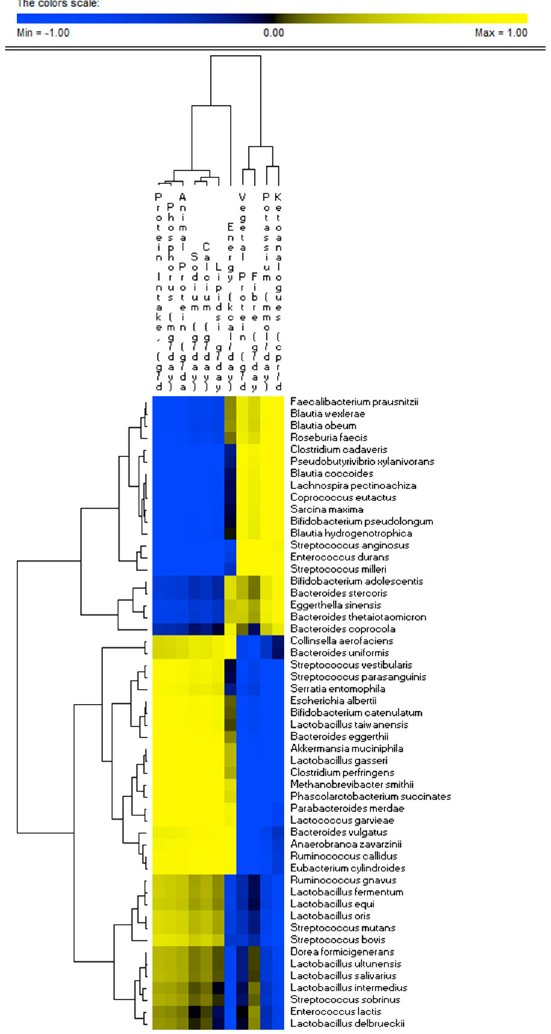
Figure 4. Correlations between bacterial species and dietary intake of CKD patients. The colors of the scale bar denote the nature of the correlation, with 1 indicating a perfectly positive correlation (yellow) and − 1 indicating a perfectly negative correlation (blue) between species and dietary intake. Only significant correlations (FDR, 0.05) are shown.